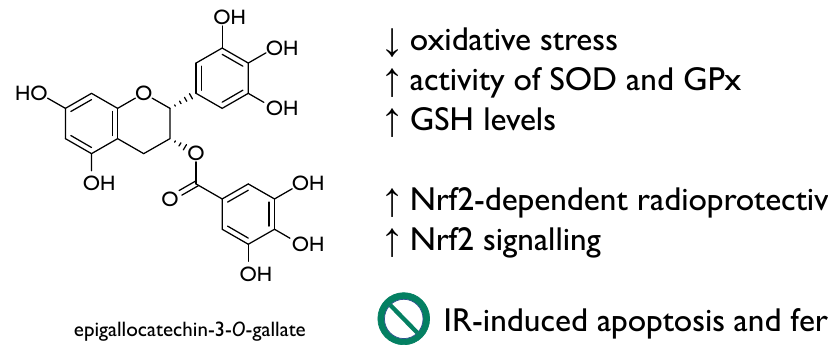
Figure 6. Epigallocatechin-3- O -gallate radioprotective mechanisms of action. Growing evidence suggests the potential benefit from green tea flavanols. Early studies supported the hypothesis of anti-genotoxic efficacy in human lymphocytes [47], and the overall prevention against ultraviolet radiation-induced DNA damage [48].